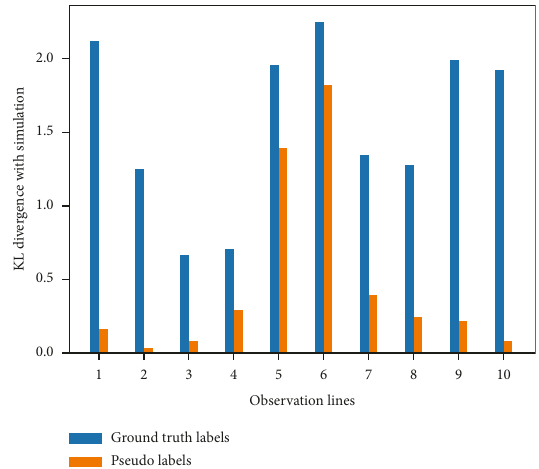
Figure 10: Comparison by KL divergence. Our segmentation model output results that are more similar to the simulation than does the model trained by the ground-truth dataset.